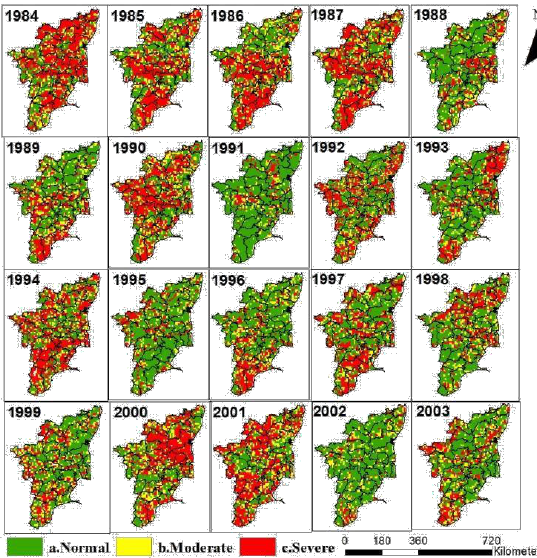
Figure 6 Drought intensity maps for 20 years during